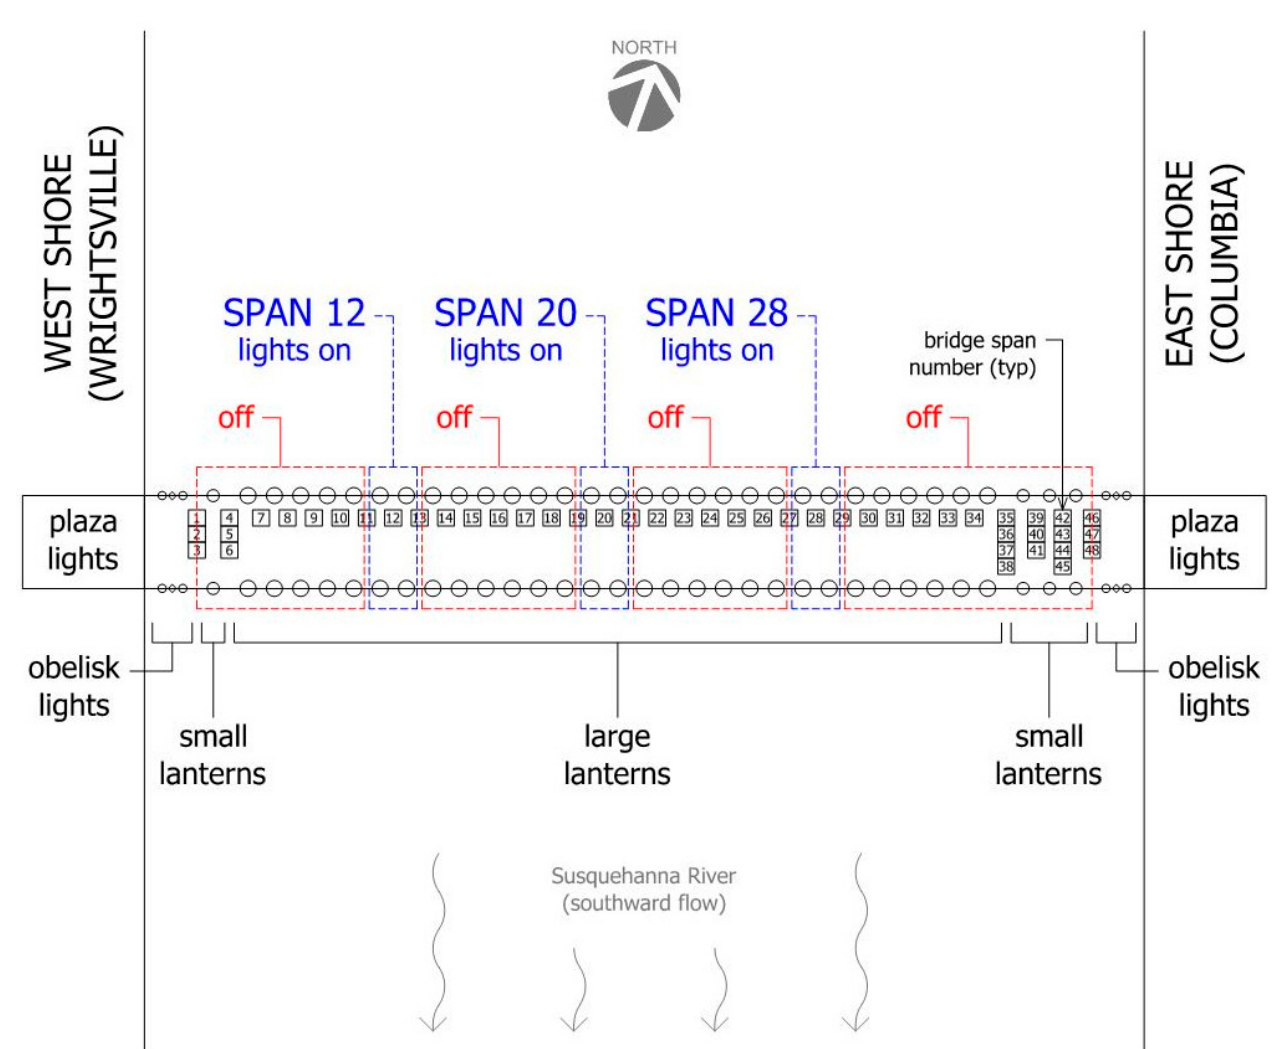
Figure 2. Schematic of the Veterans Memorial Bridge shows the three spans (span 12, 20, and 28) used to test experimental lighting conditions. Sections between the test spans and at each end of the bridge were left unlit to differentiate the test locations.